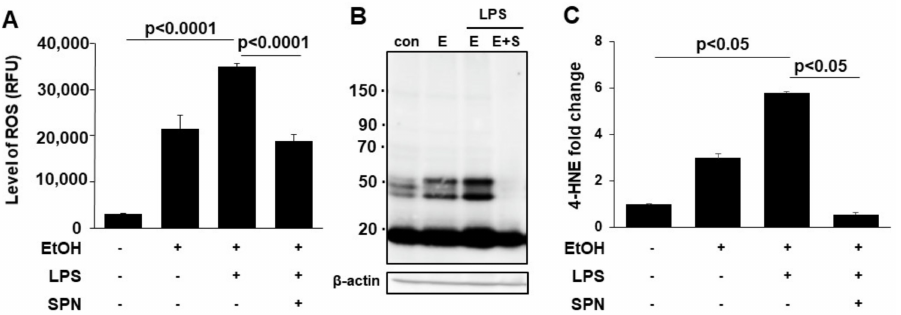
Figure 2. Spermidine prevents ethanol and LPS-induced oxidative stress. The levels of ROS were determined fluorometri- cally in livers from mice treated in the absence (control) or presence of ethanol (EtOH), LPS and/or spermidine (SPN) as indicated ( A ). Total 4-HNE protein adducts ( B ). Molecular weight markers are indicated on the left of the immunoblot in kDa. Densitometric comparison of the immunoreactive species was performed to determine relative levels of expression. Values were normalized to total β -actin levels and are plotted as fold-increase relative to control ( C ). A representative immunoblot is shown in ( B ). For each experimental condition, four mice were analyzed ( n = 4). The values in ( A , C ) represent the means of triplicate experiments ±